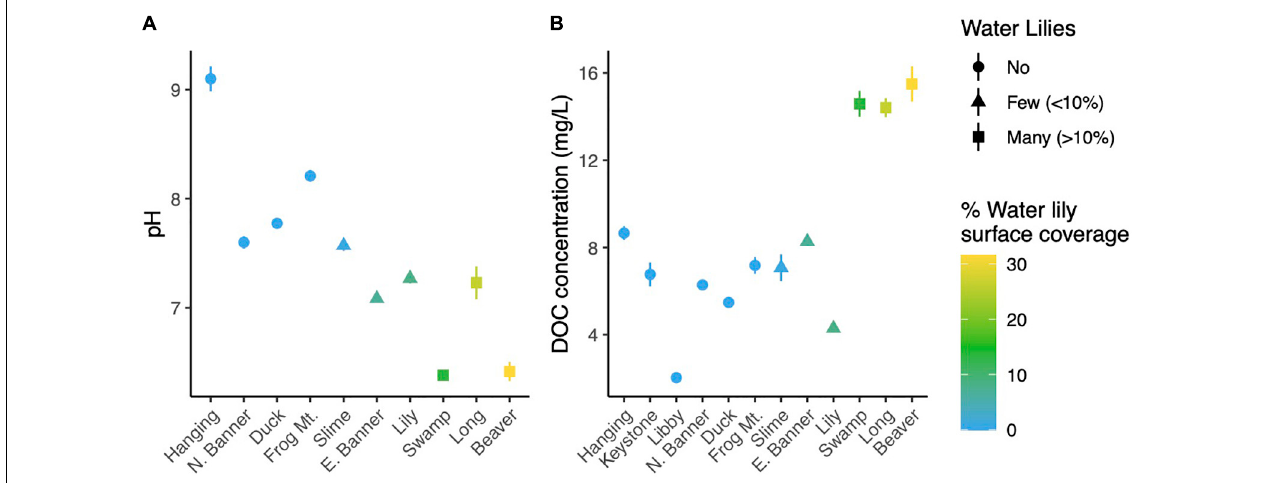
FIGURE 1 | Average pH (A) and dissolved organic carbon (B) in each lake. Error bars (where visible) represent standard